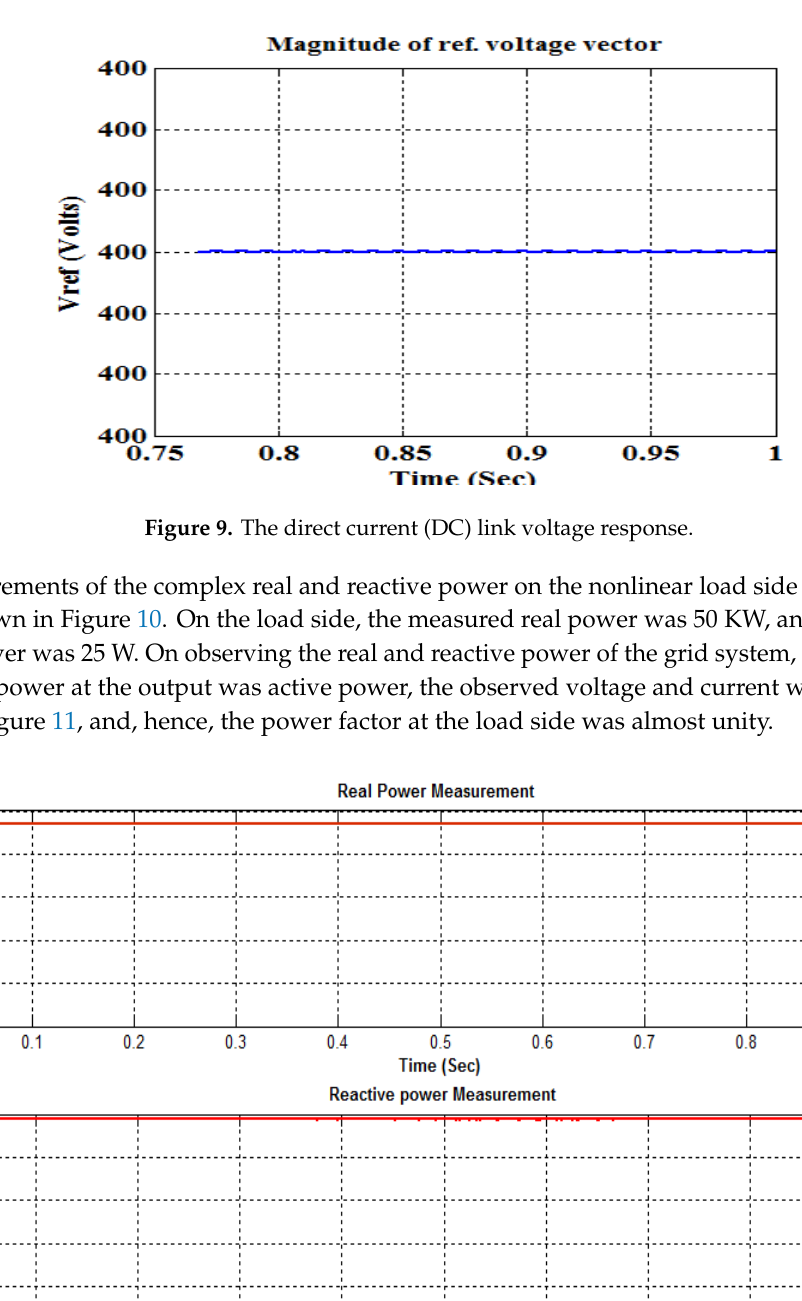
Figure 8. The membership function for output functions and the input current function.